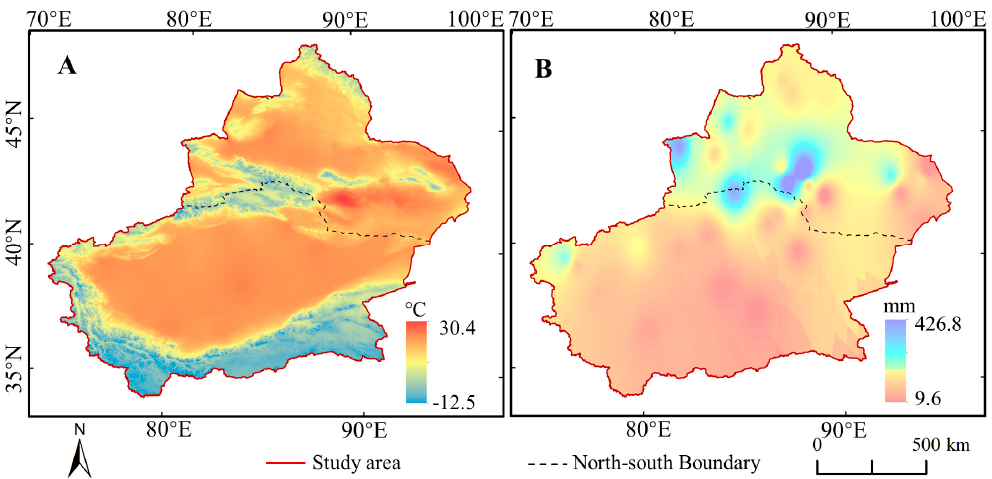
Figure 3. Yearly average temperature ( A ) and precipitation ( B ) for growing season in Xinjiang during 2000–2018. The Figure was mapping based on the daily meteorological data in 2000–2018 from the National Meteorological Data Center of China (http://data.cma.cn/).